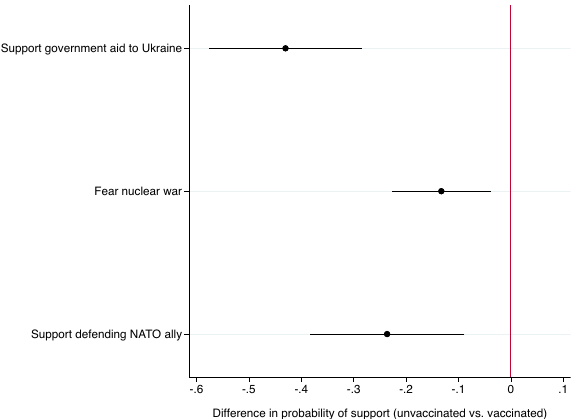
Fig. 4 Relationship between Being Unvaccinated and Attitudes toward Ukraine War. Note: Marginal effects for indicator variable identifying unvaccinated individuals from three logistic regressions. Each logistic regression also controlled for political partisanship and demographic factors. Horizontal lines present 95% con fi dence